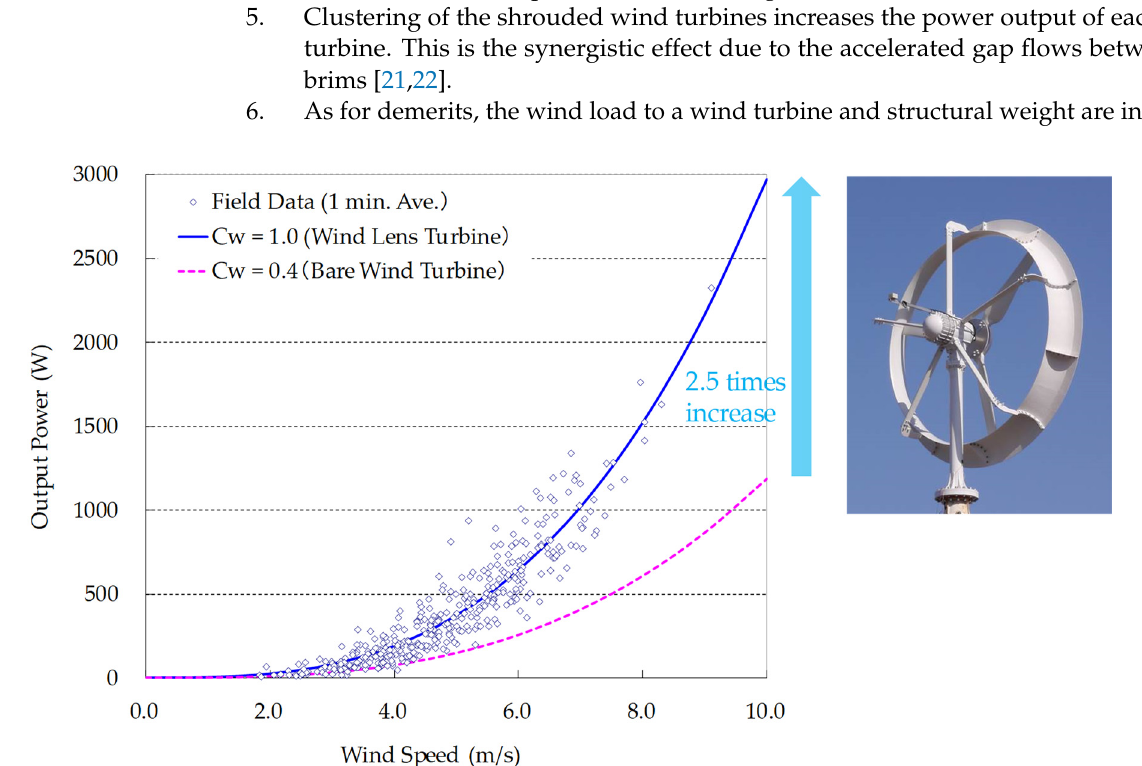
Figure 3. Field experiment of a 3 kW wind lens turbine (WLT) with a compact brimmed diffuser, a rotor diameter of 2.5 m, and a lens diameter of 3.2 m. Adapted from ref. [20].